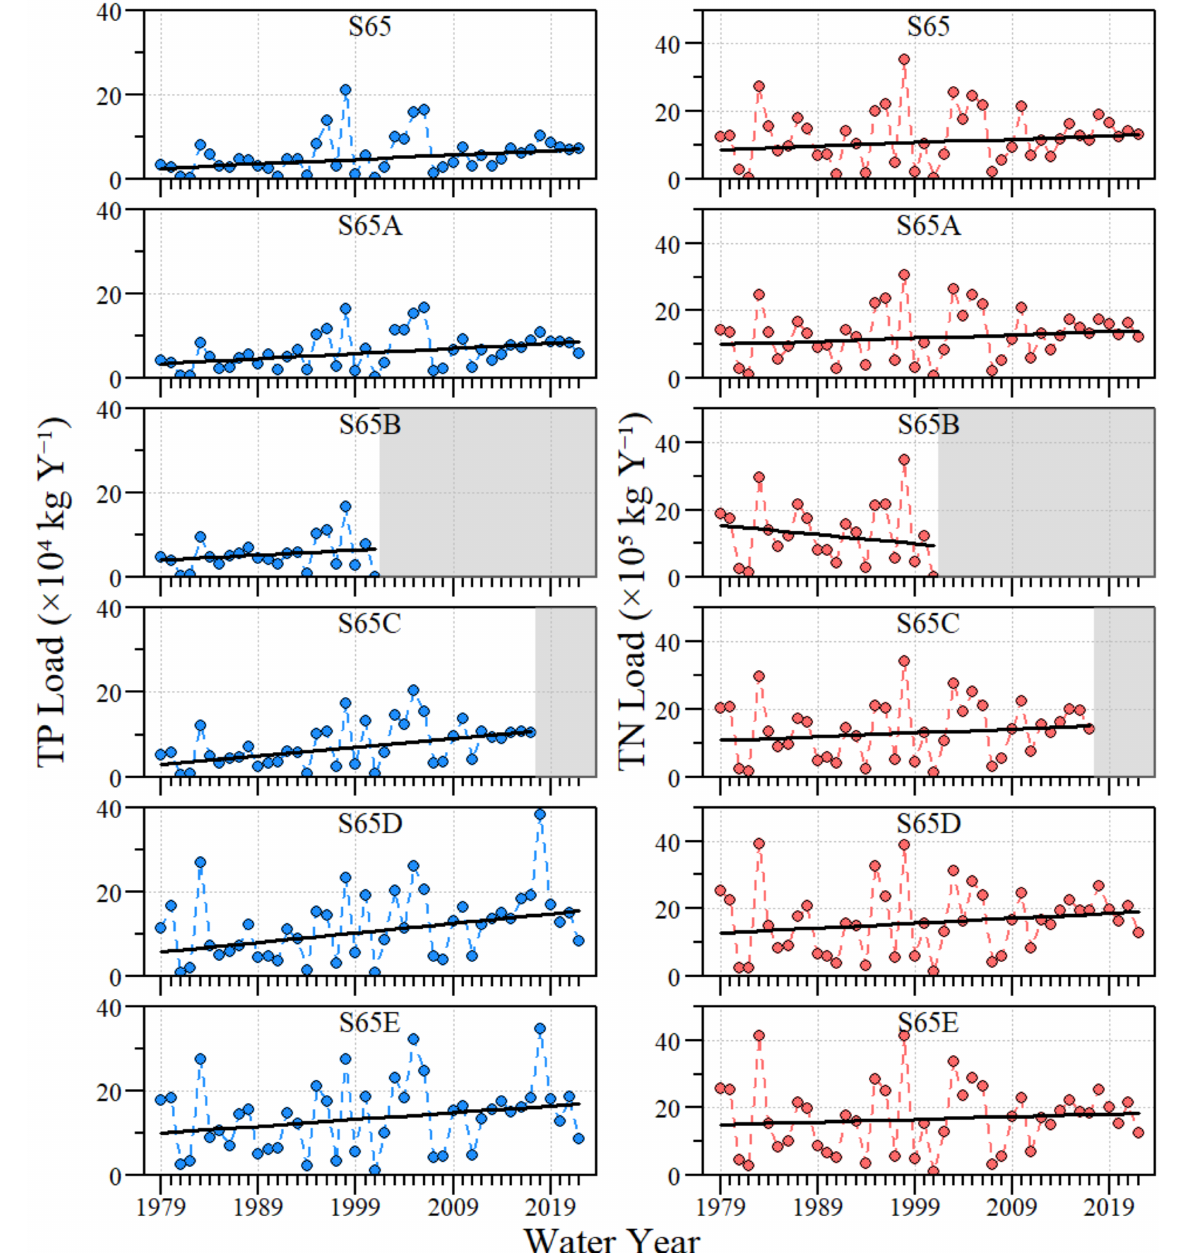
Figure 2. Total phosphorus (TP) and total nitrogen (TN) total annual load for each structure along the Kissimmee River floodplain from water year (May–April) 1979 to 2022. The black line through each time-series indicates the monotonic trend in annual values for each respective structure and parameter. Grey-shaded areas for S65B and S65C indicate when the structures were removed as part of restoration